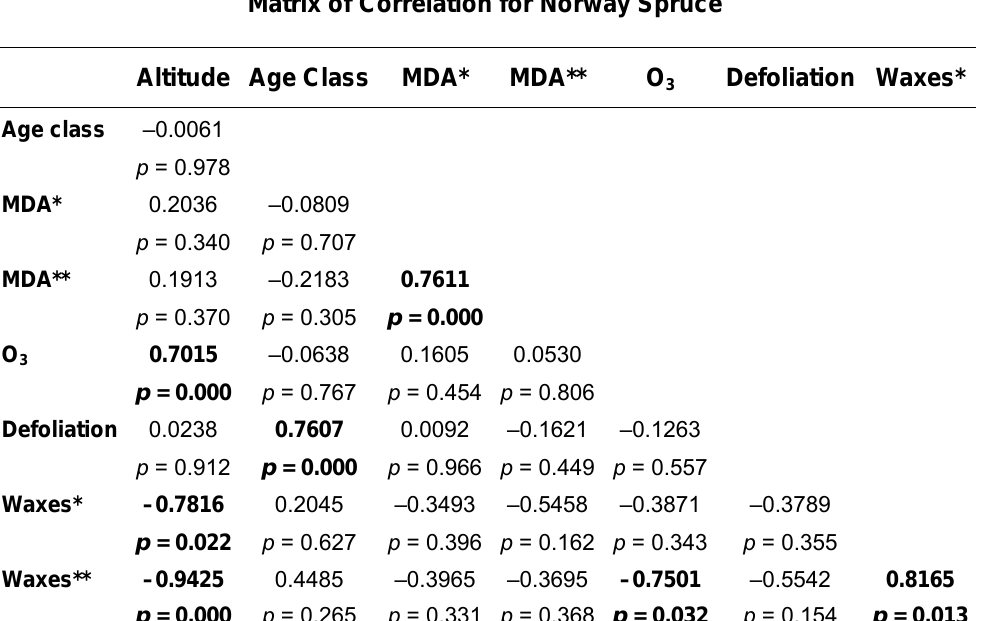
Matrix of Correlation for Norway